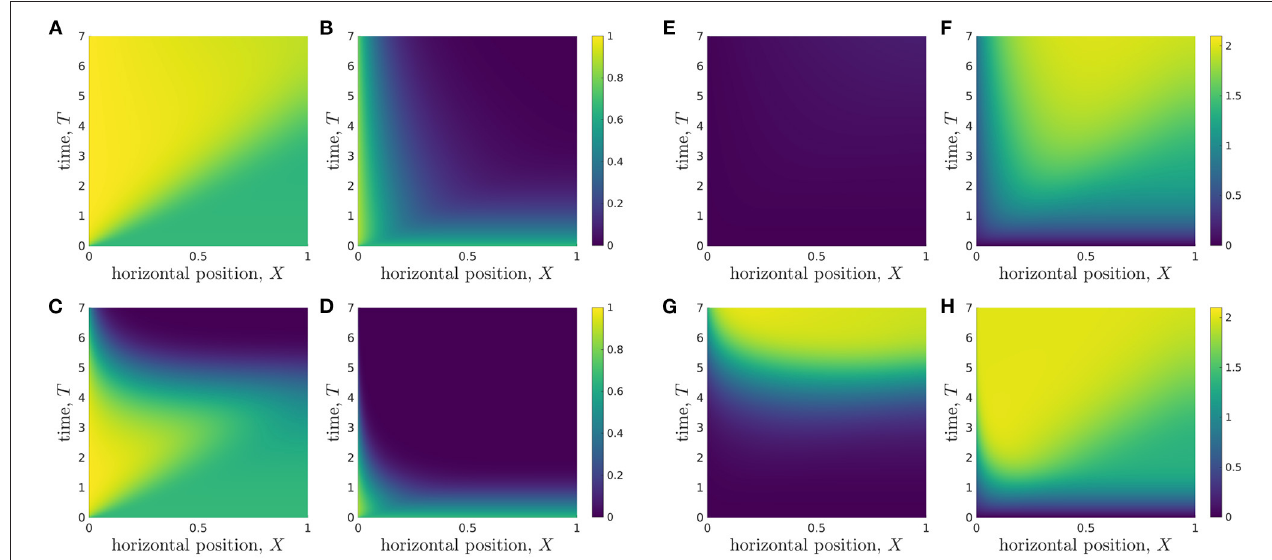
FIGURE 6 | Evolution of glucose (left grid) and lactate (right grid) concentration profiles over the duration of a typical experiment for different organoid lines under the same operating conditions. The rates of cell proliferation rates and glucose consumption per cell are: (A,E) organoid line (i), p = 1 / 6, ρ = 0.027; (B,F) organoid line (ii), p = 1 / 6, ρ = 2.7; (C,G) organoid line (iii), p = 1, ρ = 0.027; (D,H) organoid line (iv), p = 1, ρ = 2.7. The other parameters used are given in Table 3 .